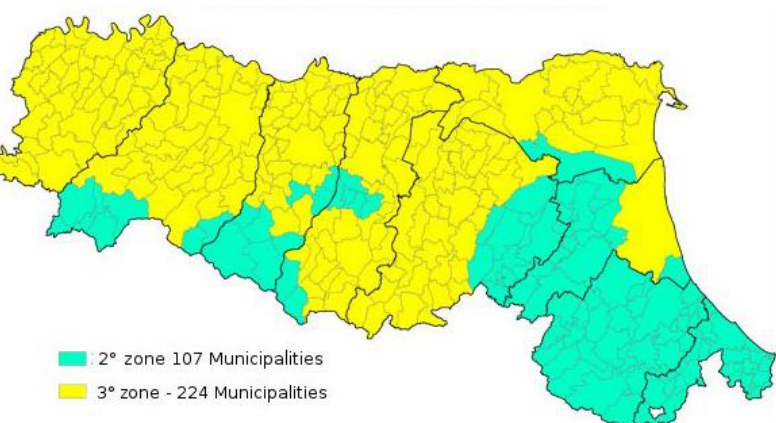
Figure 1. Seismic classification of municipalities in Emilia (https://ambiente.regione.emilia-romagna.it/en/geologia/seismic-risk/seismic-classification, accessed on 15 October 2021).